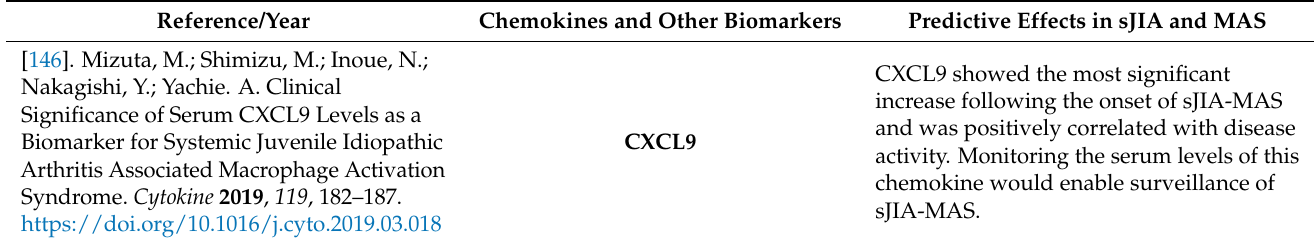
Table 4. Chemokines and other biomarkers for the diagnosis, activity, and prognosis of sJIA and